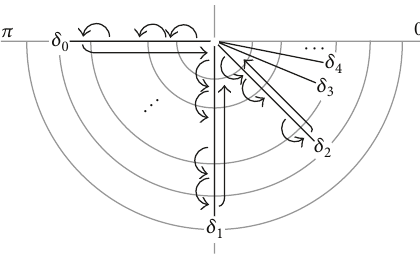
Figure 1: The map 𝑓 in Example